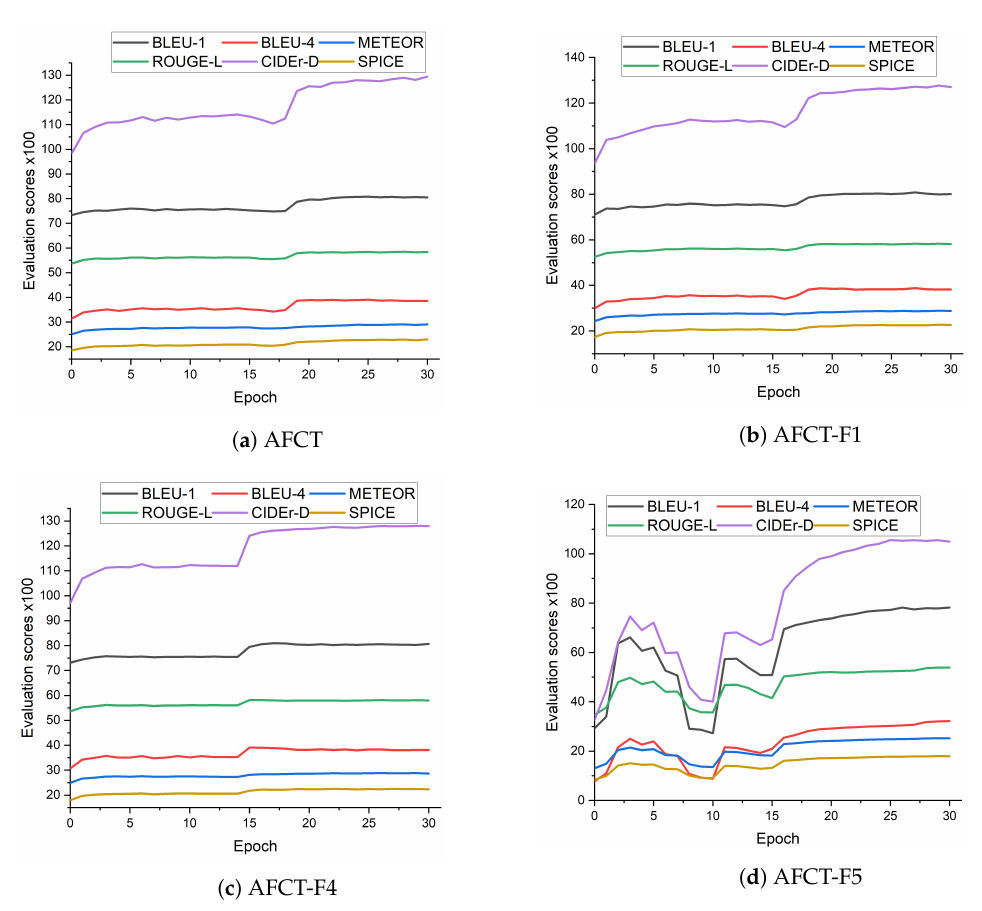
Figure 4. Graphs showing the BLEU-1, BLEU-4, CIDEr-D, METEOR, ROUGE-L, and SPICE evalua- tion scores of the AFCT model and some selected variants. ( a ) Evaluation scores for the proposed AFCT model. ( b – d ) Evaluation score graphs for AFCT-F1, AFCT-F4, and AFCT-F5. NB: decisions about when to start the CIDEr-D optimization stage were based on the CIDEr-D metric scores of the validation set rather than the CIDEr-D metric scores of the test set displayed